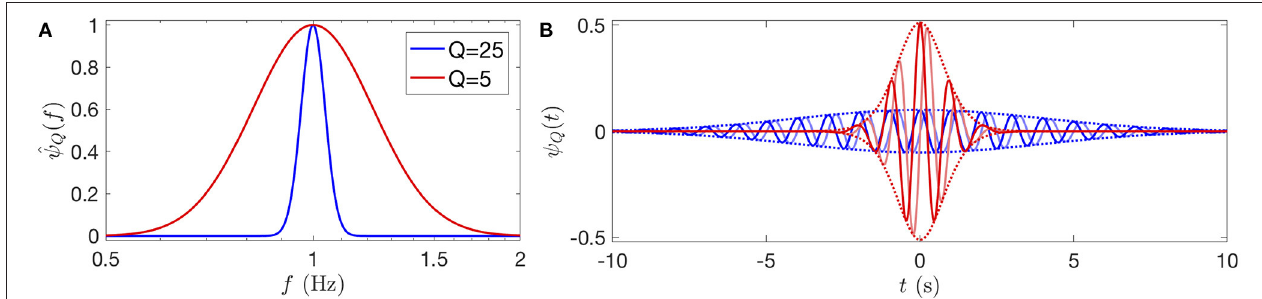
FIGURE 1 | Grossmann log-normal wavelets of quality factor Q 25 and 5 (in blue and red, respectively), represented in frequency in logarithmic scales (A) and in = time (B) , with the reference frequency f 0 1. In (B) , the real part of the wavelet is represented with a blue (respectively red) line, in quadrature, the imaginary part is a = ψ Q ( t ) light blue (respectively light red) line, and the envelope is delimited by dotted lines. The uncertainty time-frequency relation is clear here: the higher the quality ±| | factor, the more the wavelet is localized in frequency and the more it has oscillations in time. The effective number of oscillations of the wavelet are N 25 N 5 ≈